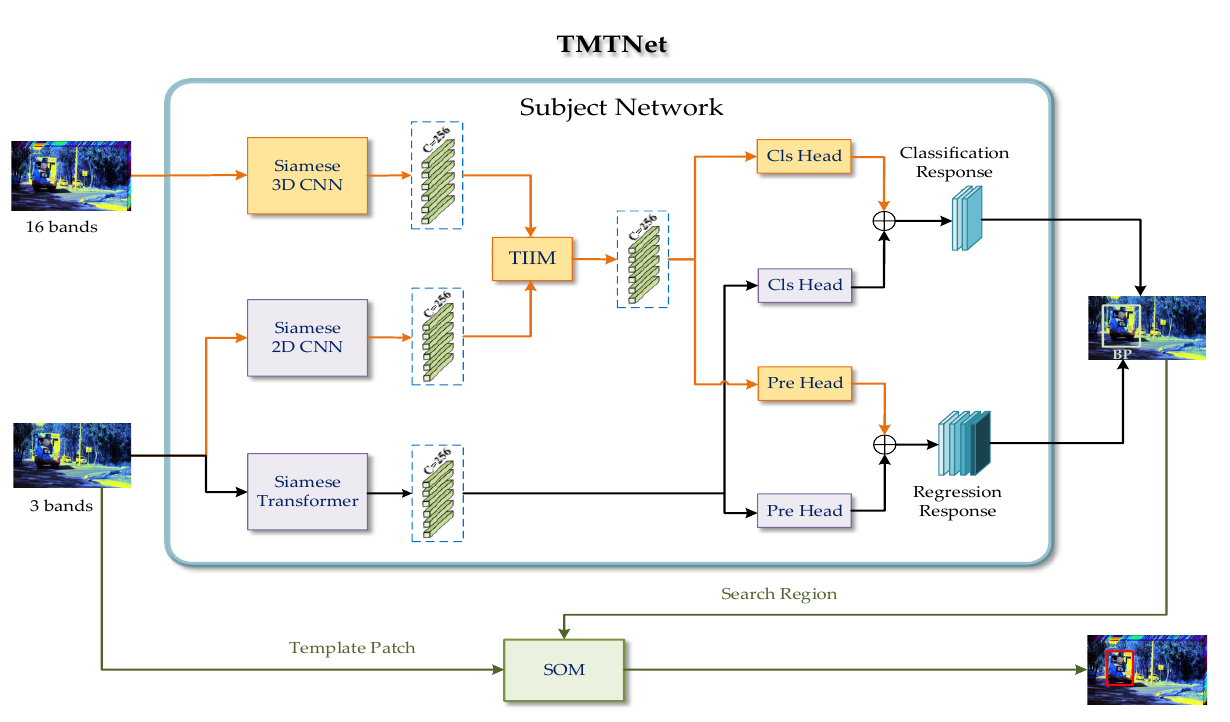
Figure 2. The proposed TMTNet’s architecture. The part with the blue border box describes the structure of the subject network. The modules connected by orange arrows in the subject network are components of the multimodality fusion information transfer subnetwork. The remaining modules are components of the RGB modality information transfer subnetwork. The yellow module is related to processing hyperspectral data, whereas the purple module is related to processing pseudocolor data. TIIM is the Transformer-based information interaction module, ⊕ represents the merge operator and SOM describes the spatial optimization module. ’BP’ represents the object’s bounding box predicted by the subject